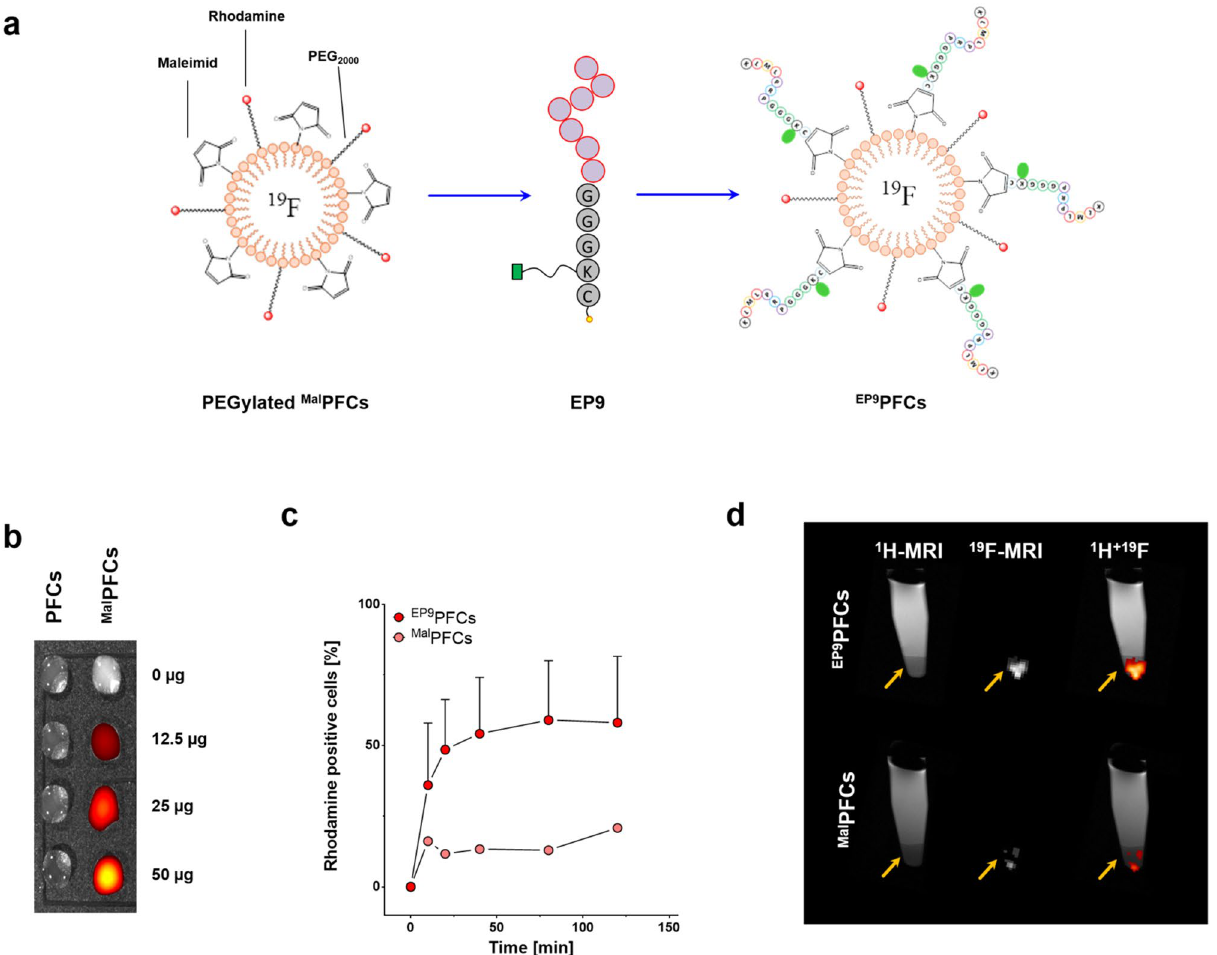
Figure 4. ( a ) Coupling of EP9 to maleimide-PFCs ( Mal PFCs): Mal PFCs are pre-formed PFCs composed of a single lipid layer, which encapsulates liquid perfluoro-15-crown-5 ether. The surface layer contains PEG 2000 - maleimide-lipids for coupling to sulfhydryl groups and rhodamine-labelled lipids to allow for fluorescence- imaging. ( b ) Increasing amounts of EP9 were incubated with Mal PFCs or conventional Rho PFCs to investigate the coupling of the free C-terminal –SH residues to the maleimide on the surface of Mal PFCs. PFCs were purified by ficoll density gradient separation and the rhodamine fluorescence signal was analysed by IVIS. The image shows an overlay of the photograph (grey) with the carboxyfluorescein fluorescence image intensity (red to yellow). ( c ) Flow cytometric analysis of EpiSCs after incubation with EP9 PFCs (red) and nonspecific Mal PFCs (light red) over a period of 120 min at 37 °C. Data show the relative amount of rhodamine positive cells (%) ± SD of n = 2–3 individual experiments. ( d ) Visualization of EpiSCs by 19 F MRI: EpiSCs were incubated with EP9 PFCs (upper panel) or Mal PFCs as control (lower panel), intensively washed with PBS, transferred to a reaction tube, pelleted by centrifugation and analyzed by combined 1 H/ 19 F MRI using standard 1 H/ 19 F RARE sequences. The left figure displays the anatomical 1 H MRI scans (left), showing the pelleted EpiSC (bottom, arrow) which appear darker in T2-weighted MRI covered by the bright PBS (bright). In the middle figure the 19 F scan is shown, and on the right the 1 H and the 19 F images have been